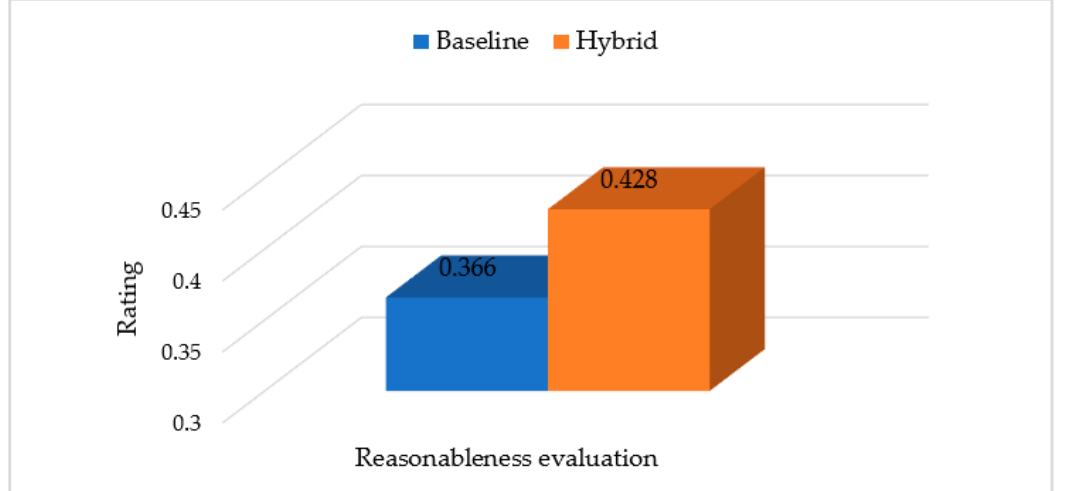
Figure 9. The rationality evaluation of the two recommendation methods.